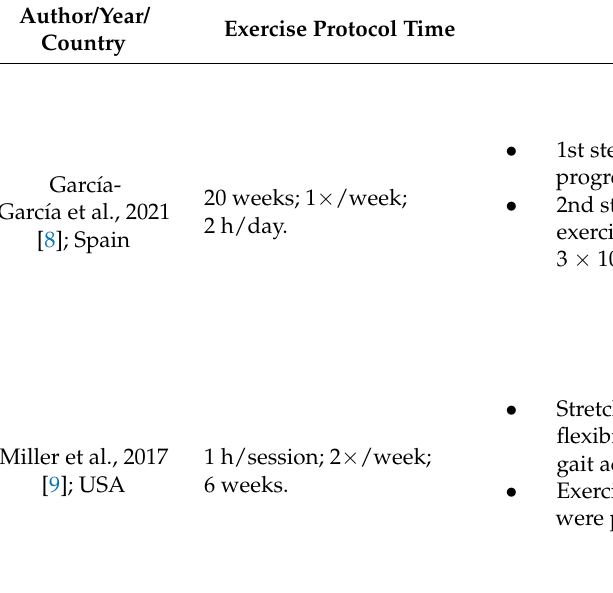
Table 5. Intervention characteristics and